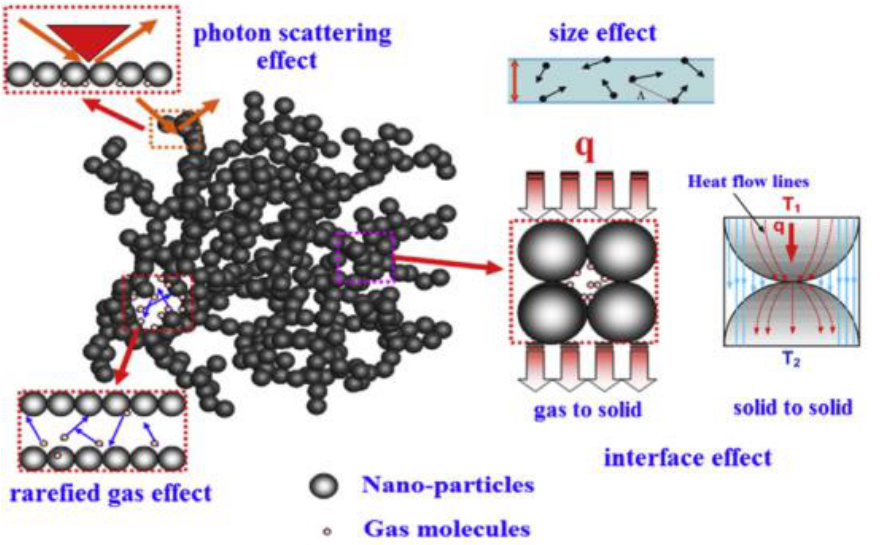
Figure 4. Common heat transfer effects of aerogel insulation materials.